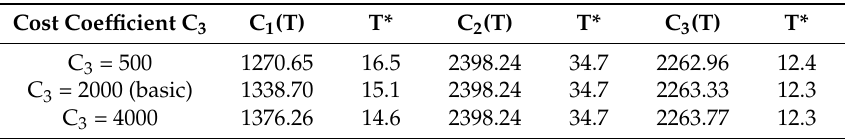
Table 10. Optimal release time T* according to cost coefficient C 3.